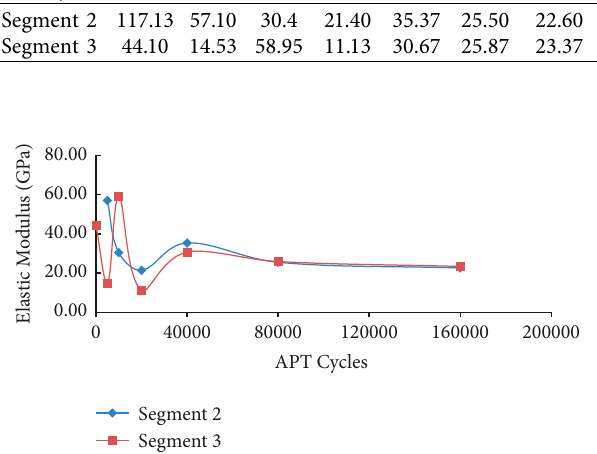
Figure 13: Relationships between the elastic moduli and the number of APT cycles for two segments.